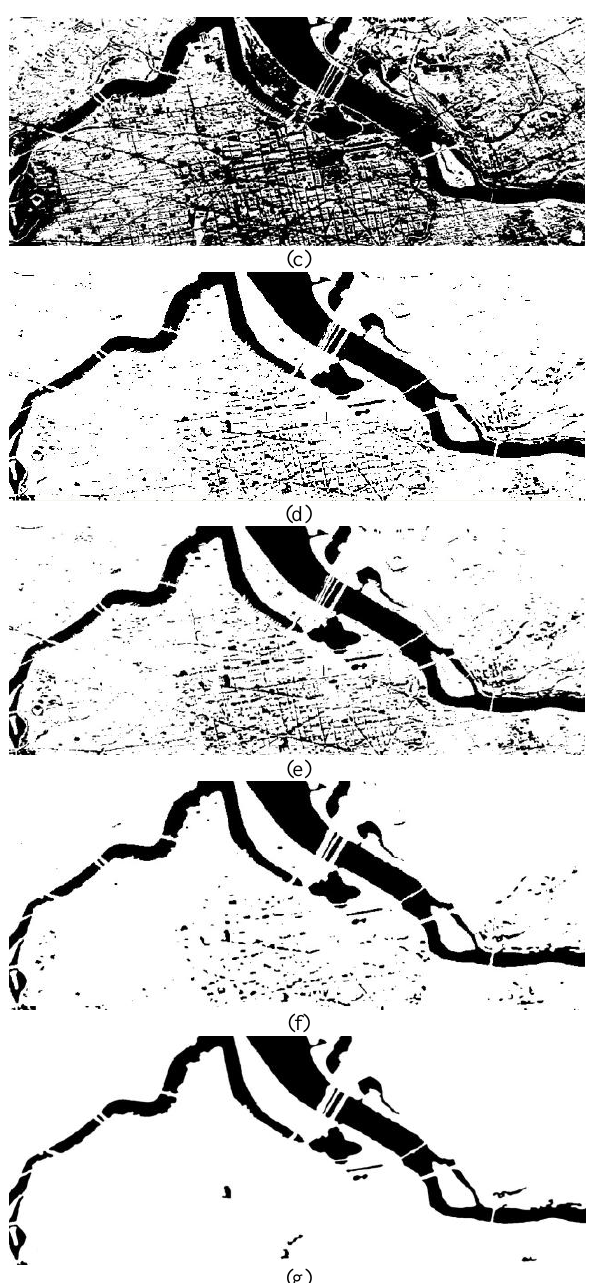
Figure.2 Water extraction